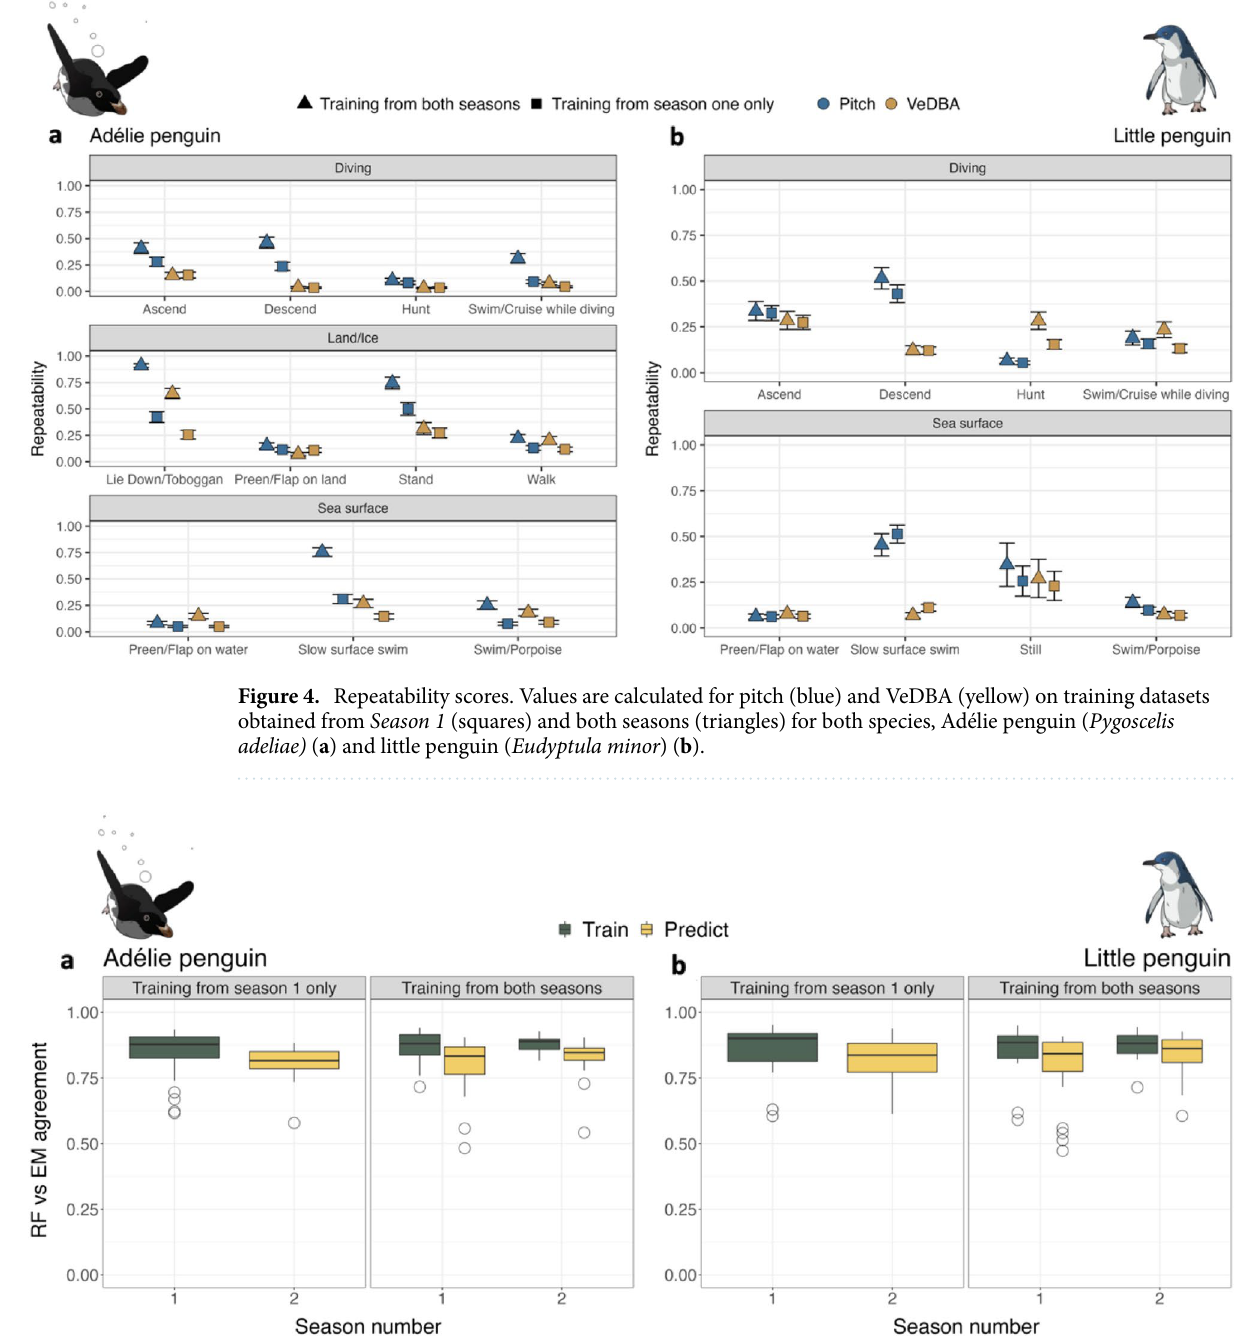
Figure 5. Agreement between machine learning approaches. Overall agreement between behavioural classification performed by the unsupervised machine learning algorithm Expectation Maximisation (EM) and one returned by the supervised machine learning algorithm Random Forest (RF), ran on data collected during foraging trips of Adélie penguins ( Pygoscelis adeliae) ( a ), and little penguins ( Eudyptula minor ) ( b